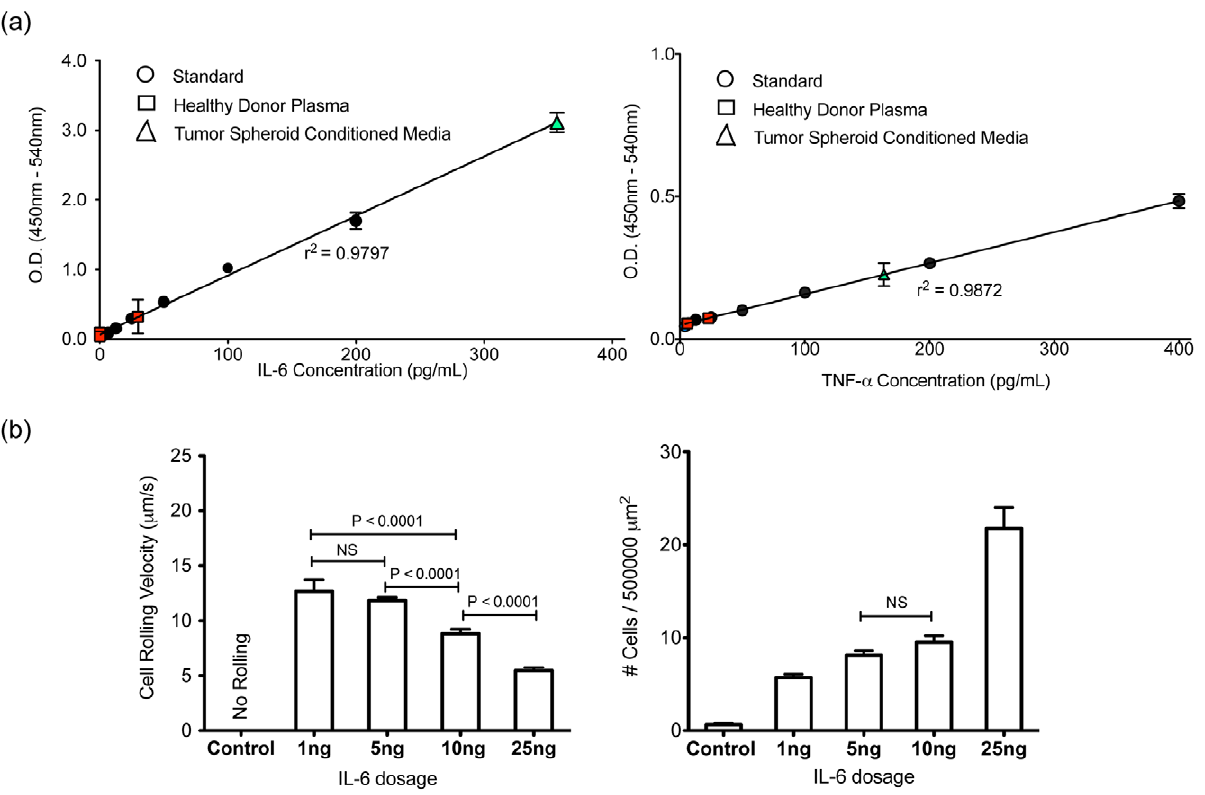
Figure 5. IL-6 and TNF- a concentrations in blood can regulate the recruitment of BCa cells to the inflamed endothelium. (a) Calculated concentrations of IL-6 (left) and TNF- a (right) of healthy female donor plasma and tumor spheroid conditioned media on ELISA standard curves. IL-6 concentration in the tumor spheroid conditioned media was diluted with equal volume of culture media to remain in the detectable range (0–200 pg/mL) of the ELISA kit. (b) Average rolling velocities (left) and average numbers of MDA cells found interacting with E-selectin coated surfaces (right) from untreated conditions and culture media spiked with a range of IL-6 concentration including 1, 5, 10, and 25 ng/mL. For the cell number analysis, all conditions are significantly different (p , 0.0001) except for the 5 and 10 ng/mL treatments. Bars represent mean 6 SEM. Two- tailed unpaired student t-test was used.